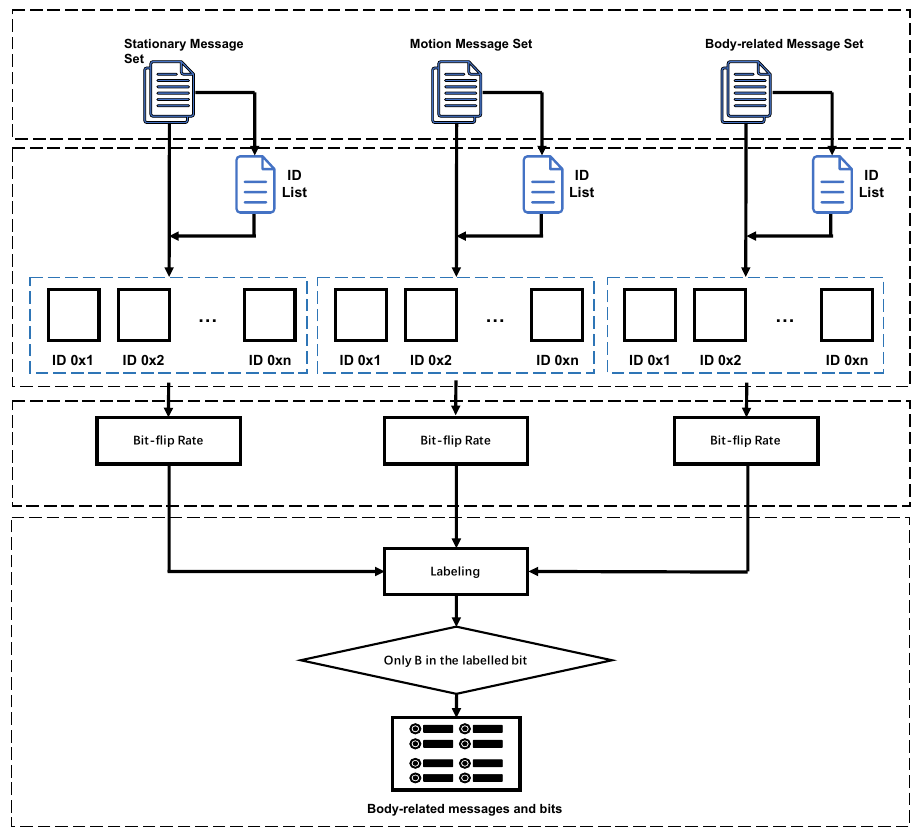
Figure 4. Labeling and filtering